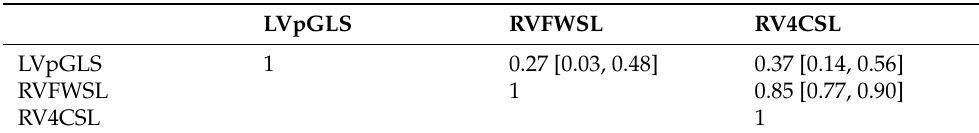
Table 2. Pearson correlation coefficient matrix between the longitudinal strain values for all samples of neonates ( n =